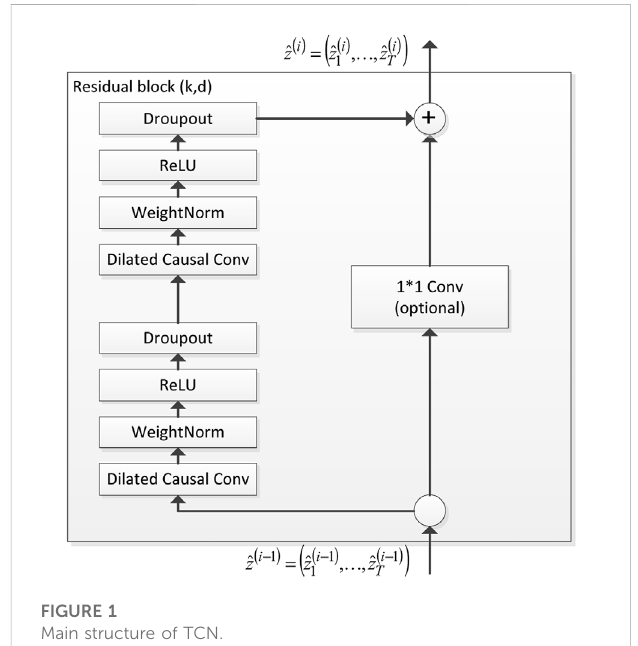
FIGURE 1 Main structure of TCN.